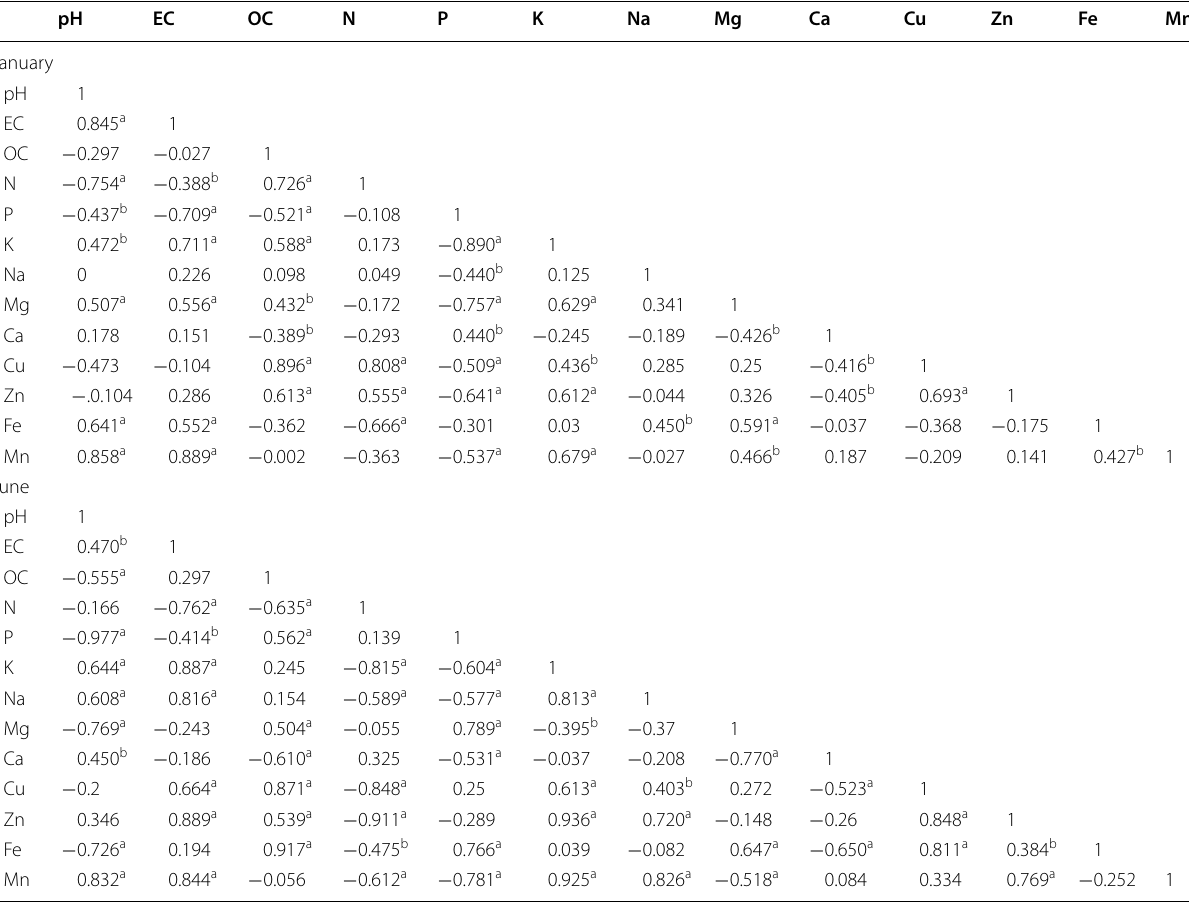
Table 2 Correlation matrix of organic and inorganic contents in agricultural soil in the floodplains of Munawar Tawi dur- ing January and June 2014